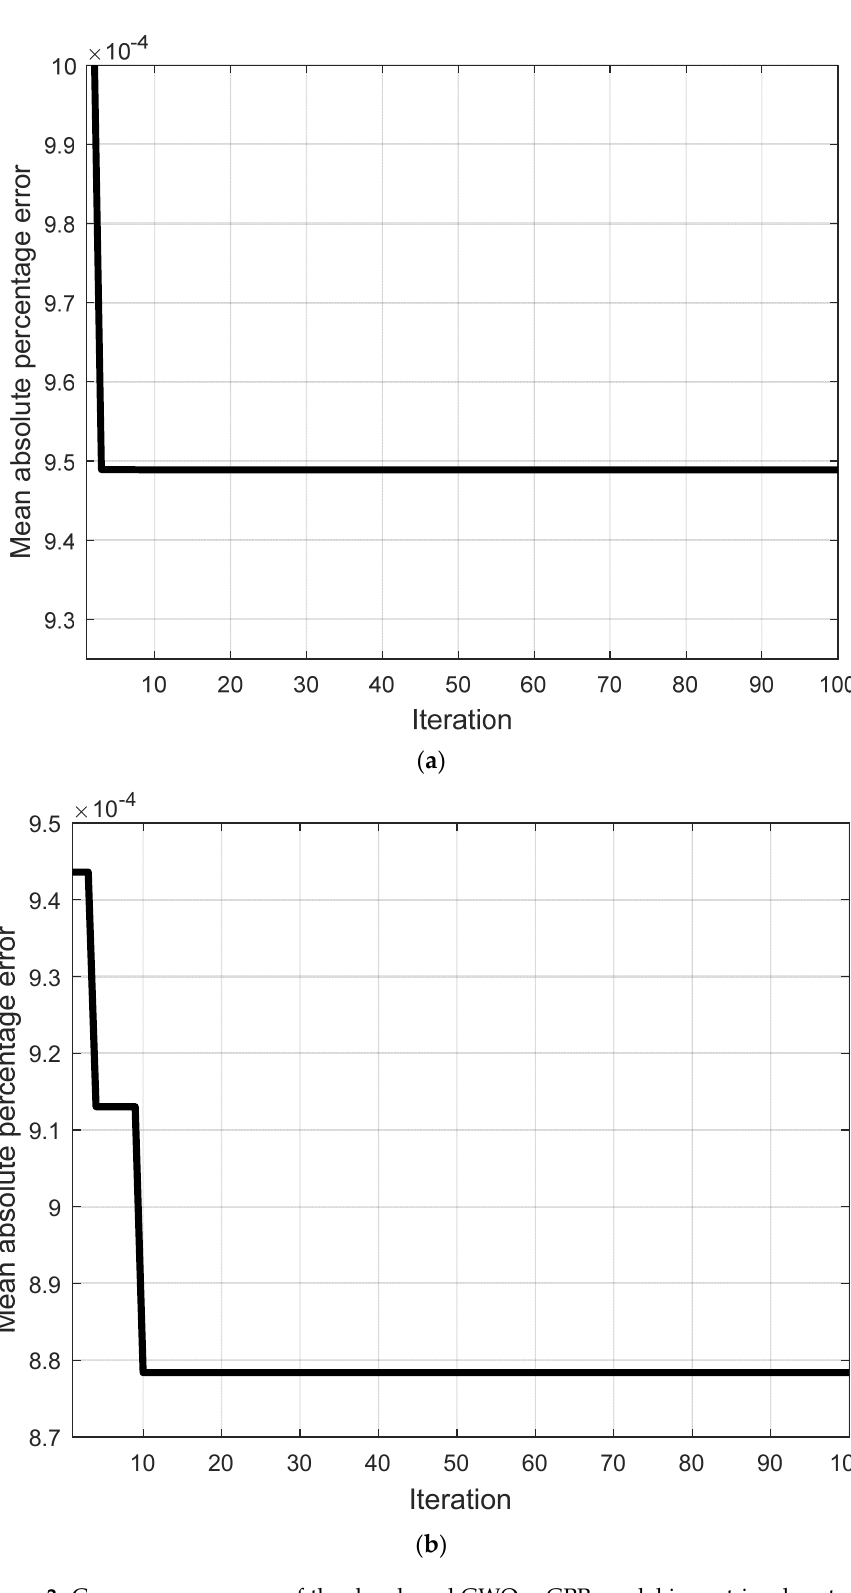
Figure 3. Convergence curves of the developed GWO − GPR model in cast-in-place tunnel liners and concrete slab on grade. ( a ) Cast in place tunnel liners. ( b ) Concrete slab on grade.